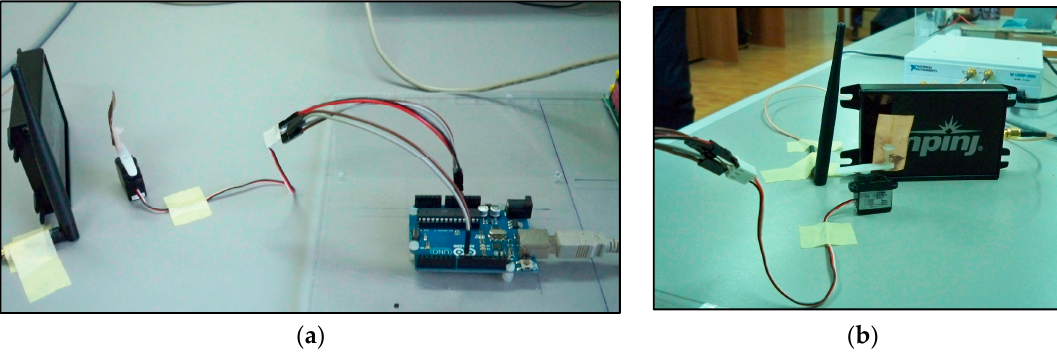
Figure 14. Setup of the second experimental test: ( a ) stepper micro motor connected to Arduino UNO (Arduino LLC, Ivrea, Italy); ( b ) stepper micro motor with a target in the presence of Tx and Rx antennas.